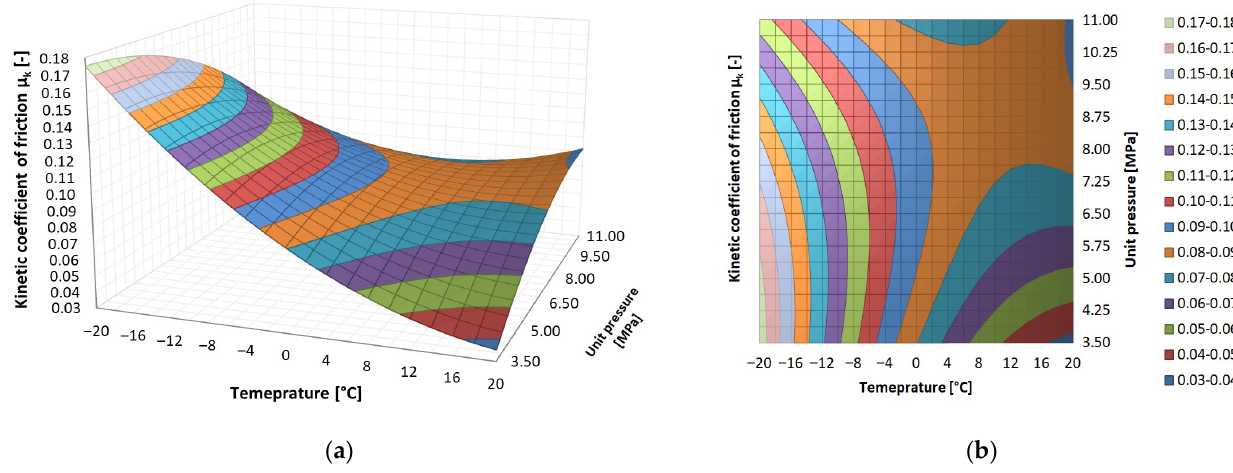
Figure 7. Dependence of kinetic friction coefficient μ k on temperature and contact pressure for PE-HD: ( a ) surface graph, ( b ) area graph.